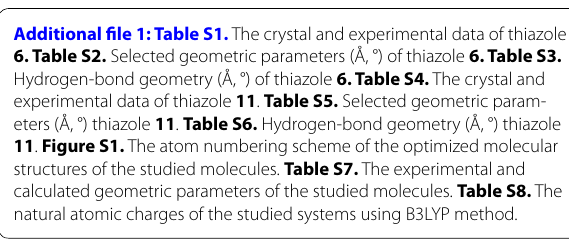
Additional file 1: Table S1. The crystal and experimental data of thiazole 6. Table S2. Selected geometric parameters (Å, °) of thiazole 6. Table S3. Hydrogen‑bond geometry (Å, °) of thiazole 6. Table S4. The crystal and experimental data of thiazole 11 . Table S5. Selected geometric param‑ eters (Å, °) thiazole 11 . Table S6. Hydrogen‑bond geometry (Å, °) thiazole 11 . Figure S1. The atom numbering scheme of the optimized molecular structures of the studied molecules. Table S7. The experimental and calculated geometric parameters of the studied molecules. Table S8. The natural atomic charges of the studied systems using B3LYP